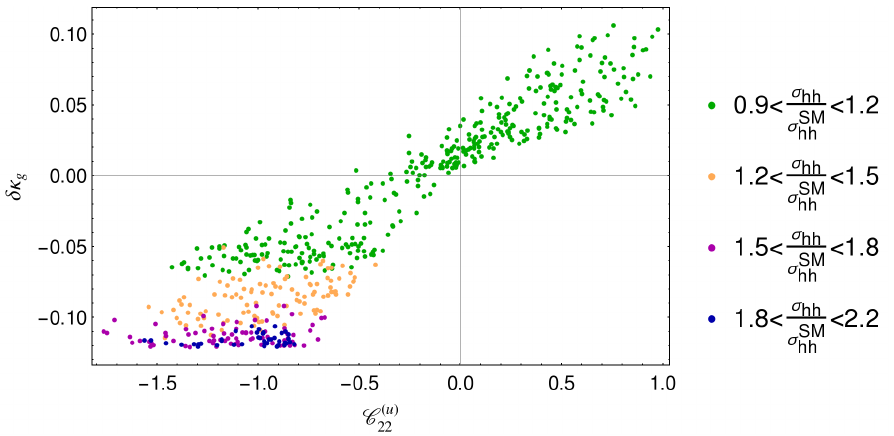
Figure 11. Values of δκ γ and δκ g for the points of the scan, in colors the values of σ hh /σ SM blue and violet lines correspond to the 1 σ and 2 σ experimental contours from [37]. The red dot is the central value of the measurement.